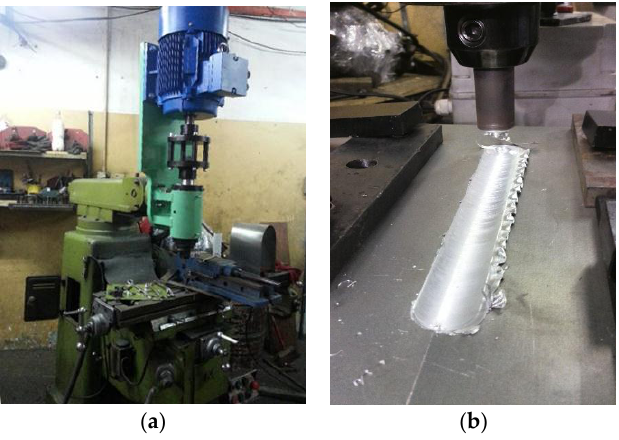
Figure 2. (a) A vertical milling machine used for FSW experiments. ( b ) The real shape of fixture